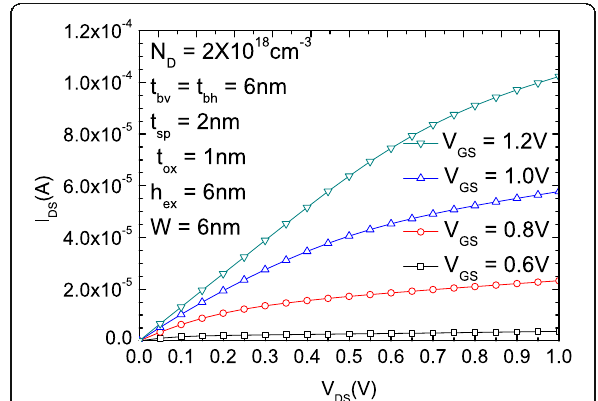
Fig. 4 I DS - V DS characteristic of the proposed RGUC FET with optimized device